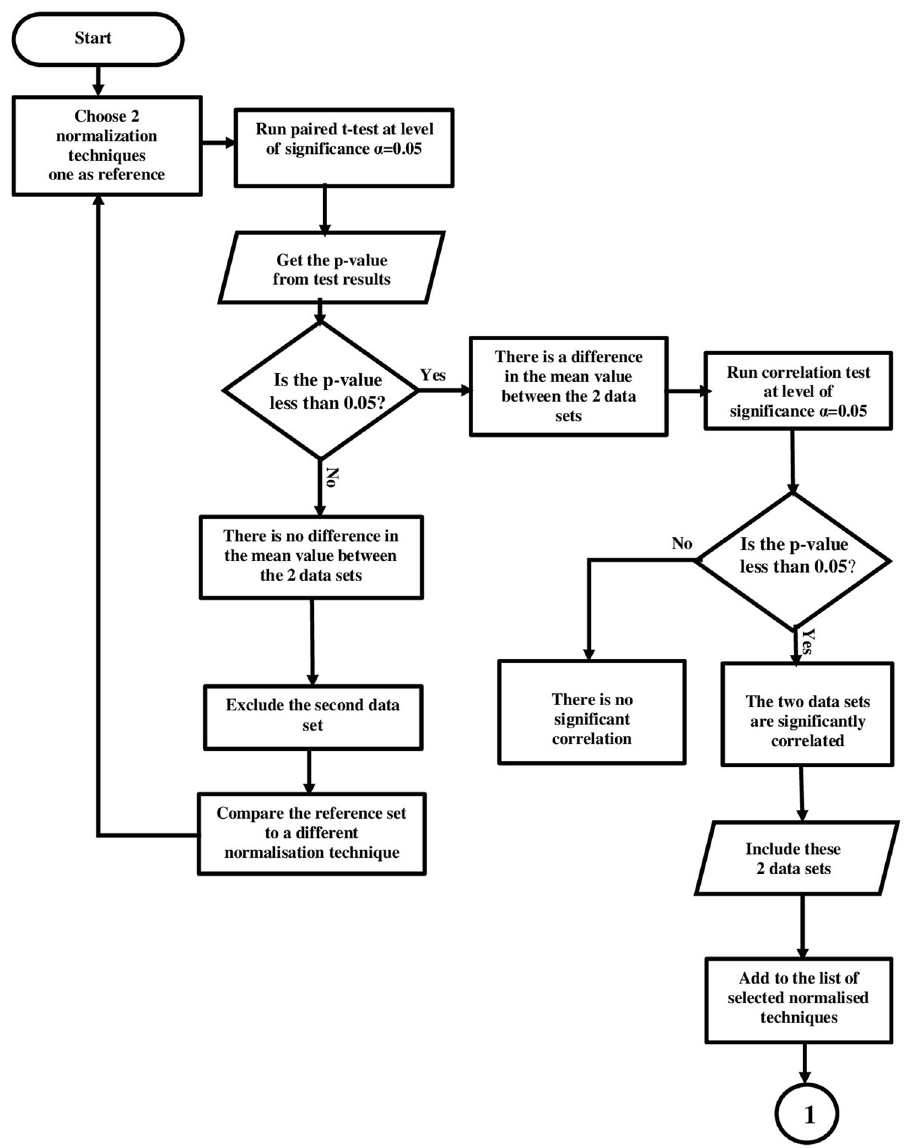
Figure 5. Statistical analysis sequence flow chart (Part